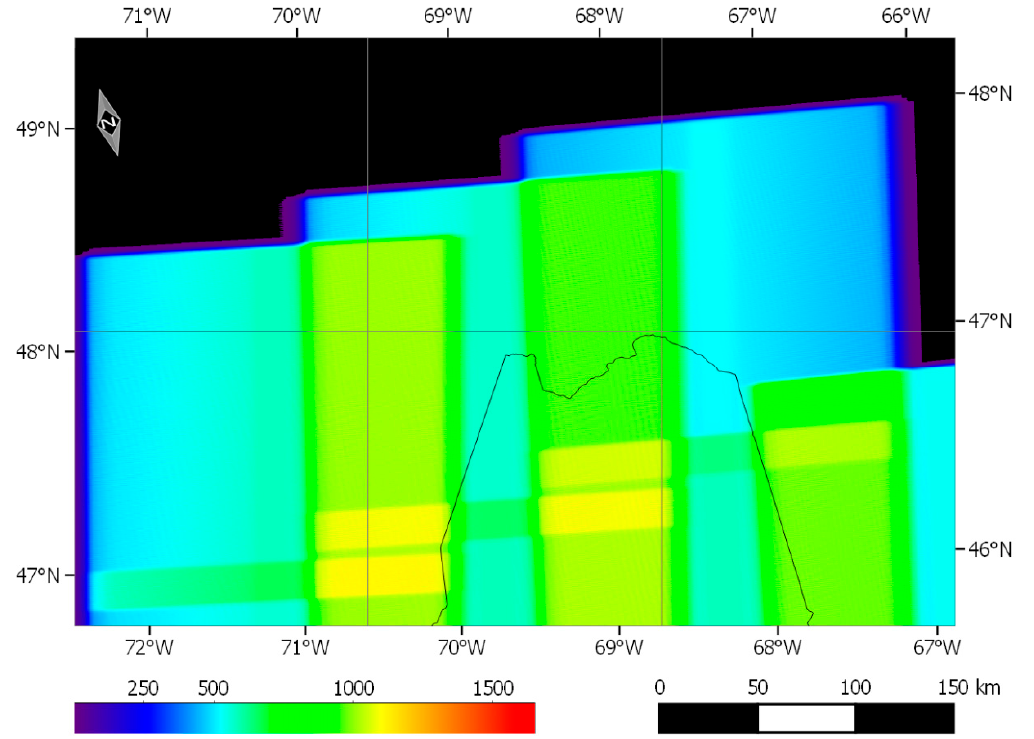
Figure 5. Example detailed spatial subset of Figure 4a over the northern tip of Maine (state boundary in black) showing the total number of non-fill Landsat 4 TM, 5 TM and 7 ETM+ observations over the 36 year study period for six ARD tiles (h29 to h31, v01 to v02).